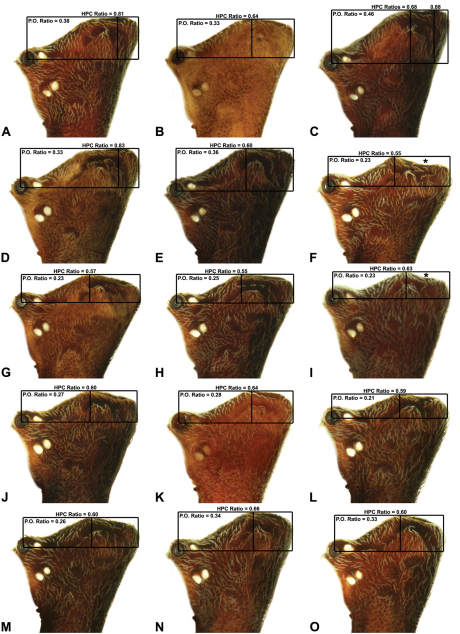
Lateral ‘head’ profiles of females of species of Austrarchaea from mid-eastern Australia, showing variation in carapace shape as quantified by the post-ocular ratio (P.O. Ratio) and ratio of highest point of carapace relative to post-ocular length (HPC Ratio): A, allotype A. alani sp. n.; B, allotype A. aleenae sp. n.; C, allotype A. judyae sp. n.; D, allotype A. raveni sp. n.; E, allotype A. harmsi sp. n.; F, allotype A. monteithi sp. n.; G, allotype A. cunninghami sp. n.; H, allotype A. dianneae sp. n.; I, A. nodosa (Forster, 1956); J, allotype A. platnickorum sp. n.; K, allotype A. binfordae sp. n.; L, A. milledgei sp. n. (WAM T112568); M, allotype A. mascordi sp. n.; N, allotype A. smithae sp. n.; O, allotype A. mcguiganae sp. n. Asterisks (*) denote concave depressions.